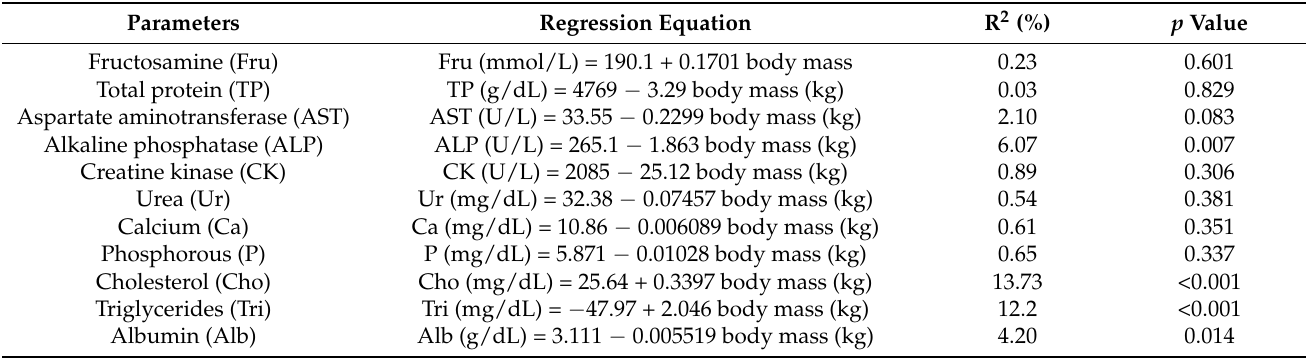
Table 6. Results of regression analysis between body mass and biochemical parameters among adult capybaras (animals from human-modified and natural landscapes were all analyzed